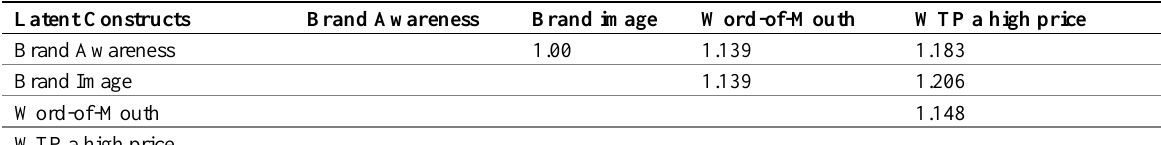
Table 5: Results of Collinearity Statistics